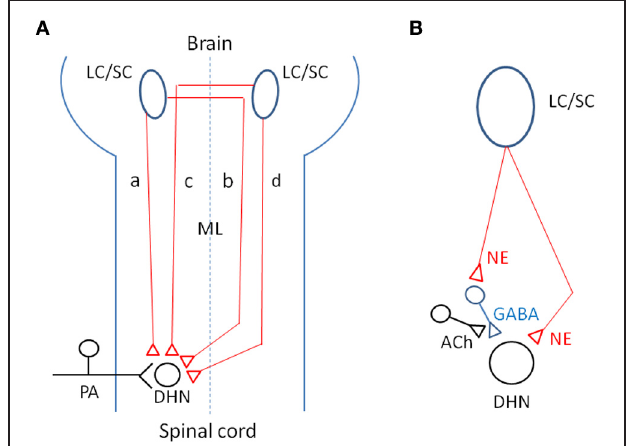
FIGURE 12 | (A) Schematic representation of four CSIPs demonstrated. (a) In ipsilaterally projecting neurons, axons descend the ipsilateral dorsolateral funiculus or ventrolateral funiculus to terminate in the dorsal horn on the side of the descending projection. (b) In ipsilaterally projecting neurons, axons cross the midline within the brain, travel through the contralateral ventrolateral funiculus and recross the midline at spinal segmental levels. (c) In contralaterally projecting neurons, axons cross the midline within the brain and travel through the dorsolateral funiculus to terminate in the dorsal horn on the side of the descending projection. (d) In contralaterally projecting neurons, axons descend through the ipsilateral ventrolateral funiculus and cross the midline at spinal segmental levels. (B) Possible neurotransmitters related to coeruleospinal inhibition of nociceptive signals in the dorsal horn (see text in detail). Keys for the brain and spinal cord are indicated by abbreviations: LC/SC, locus coeruleus/subcoeruleus; ML, midline; PA, primary afferents; DHN, dorsal horn neuron; NE, norepinephrine; ACh, acetylcholine; GABA, gamma-aminobutyric